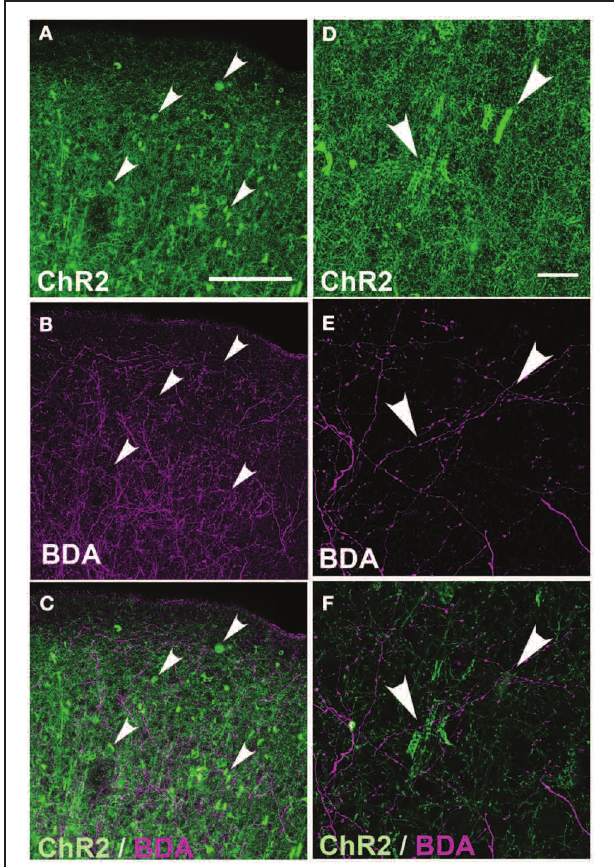
FIGURE 4 | Absence of axonal swellings on intermixed ChR2-negative axons. (A) ChR2 + axons in S1 of P156 rat, showing numerous swellings. (B) Intermixed callosal axons from contralateral S1, anterogradely labeled by BDA injection and visualized with Alexa-647. Note absence of swellings. (C) Overlay. (D–E) Higher magnification of ChR2 + axons and BDA-labeled callosal axons. All images in (A–E) are maximum Z-projection confocal images. (F) Overlay of single confocal section of ChR2 + axons on top of image (E) of callosal axons. Scale bar is 500 μ m for (in A for A–C ) and 20 μ m for (in D for D–F ). Arrows show locations of ChR2-positive axonal